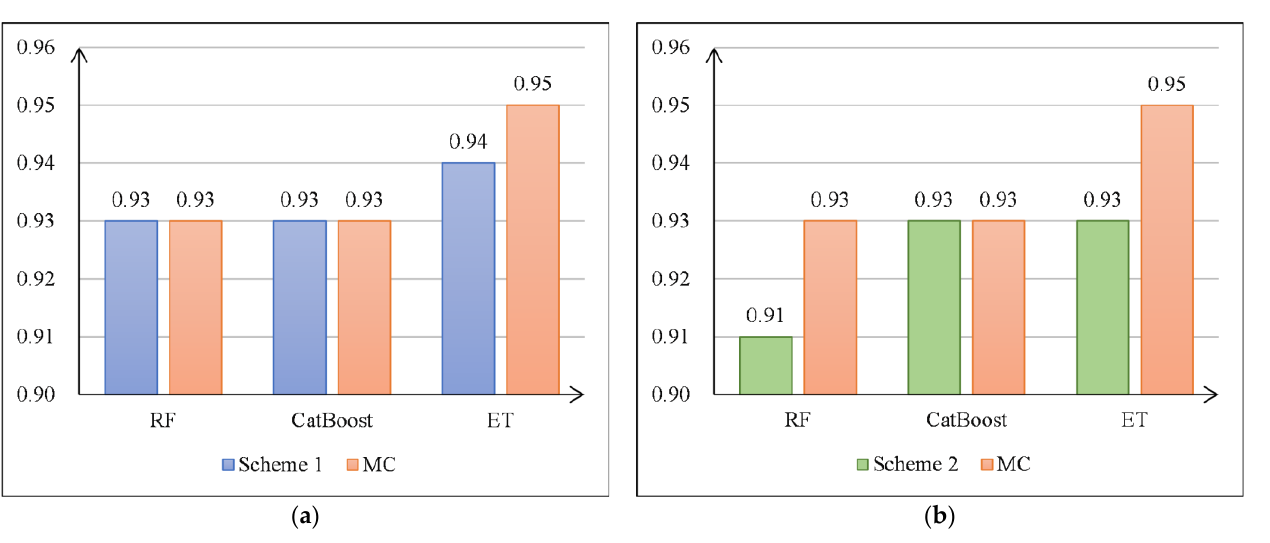
Figure 8. F1 scores for rice under different comparison schemes. ( a ) MC compared with Scheme 1, ( b ) MC compared with Scheme 2.